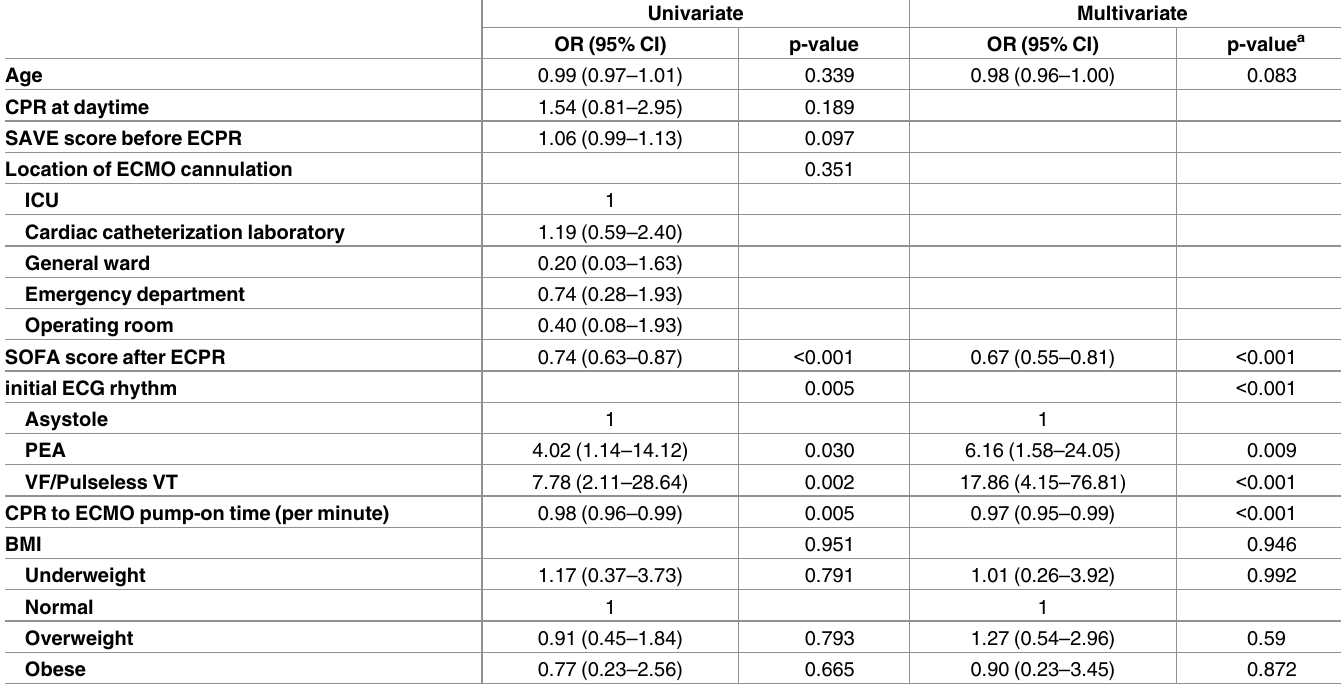
Table 4. Risk factors for survival to hospital